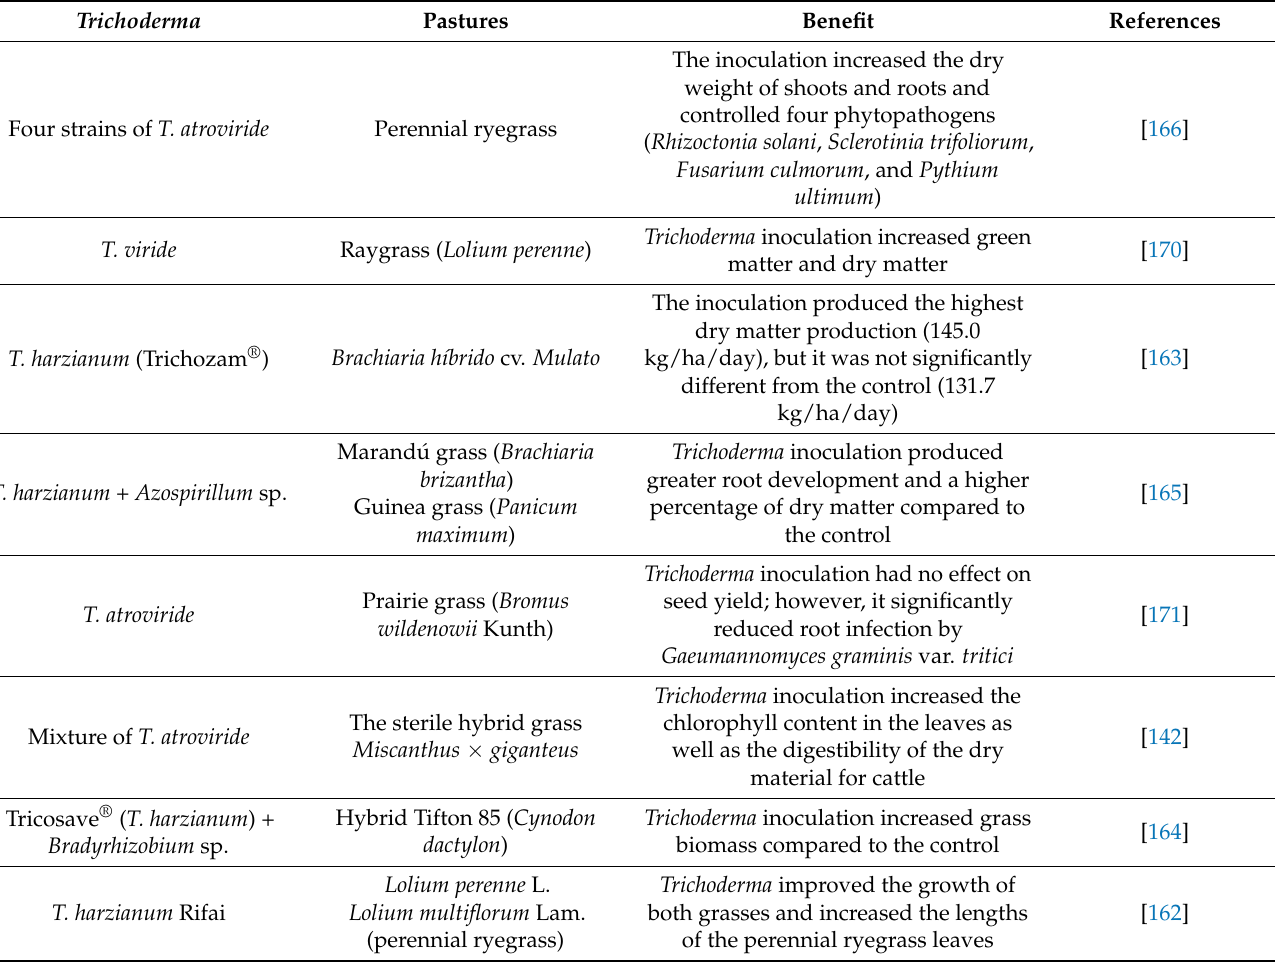
Table 2. Species of the genus Trichoderma used in the promotion of pasture